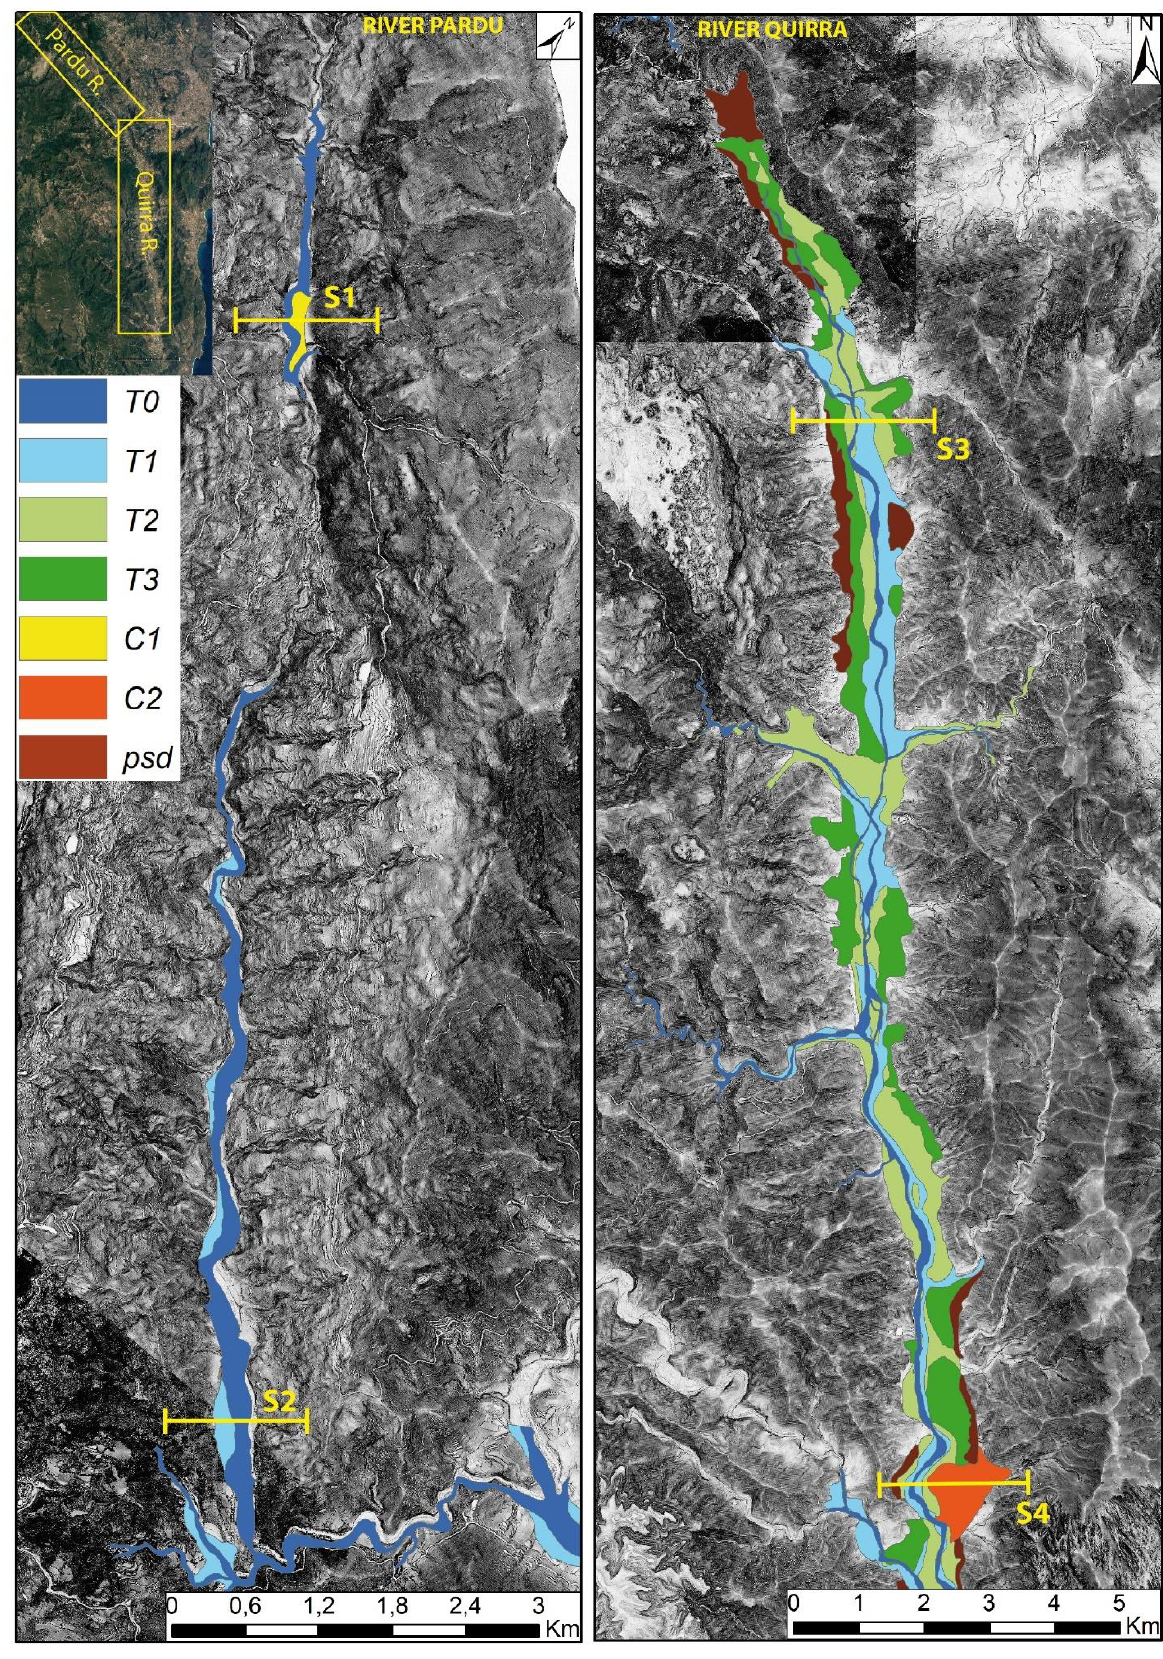
Figure 13 . Map of the distribution of alluvial deposits in Rio Pardu and Rio Quirra. Figure 13. Map of the distribution of alluvial deposits in Rio Pardu and Rio